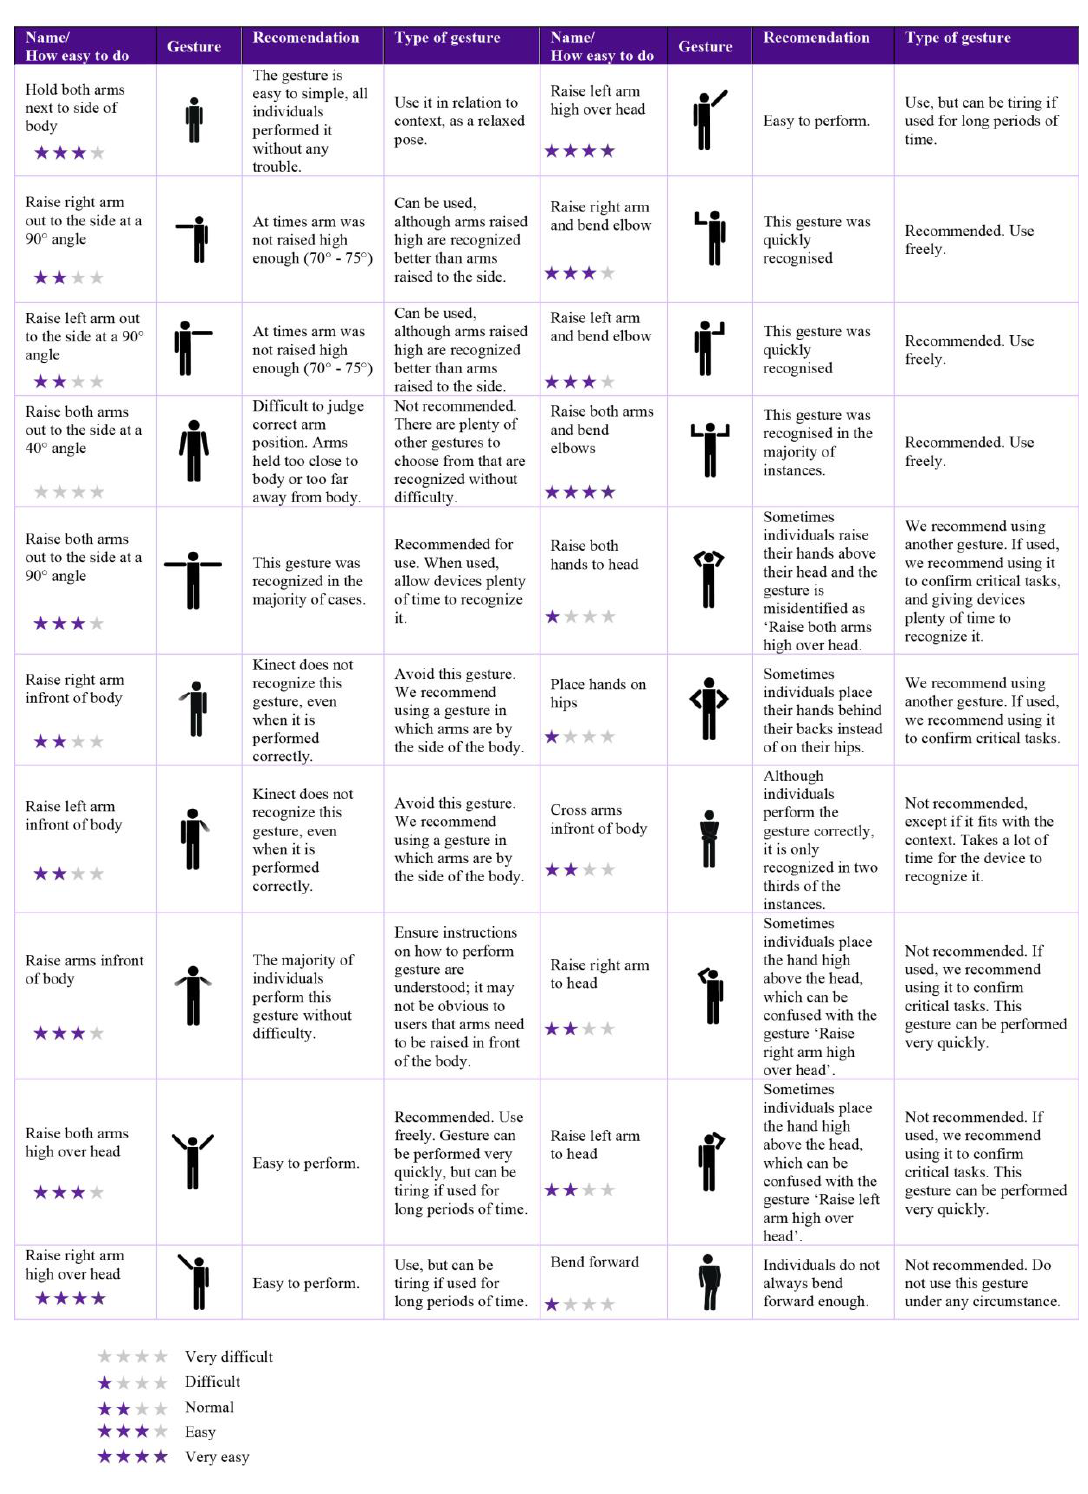
Figure A1. Guide: full-body gestures recommendation.